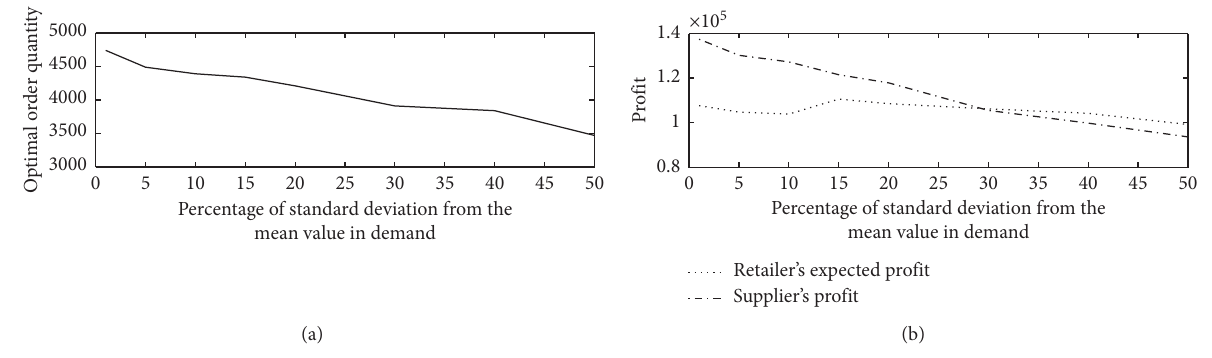
Figure 4: The impact of demand uncertainty on the optimal order